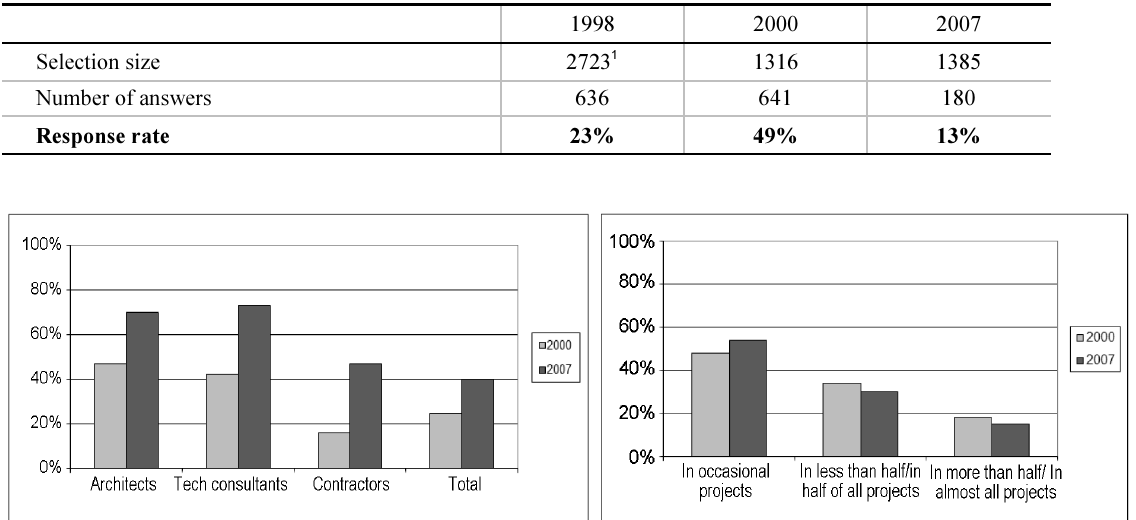
Table 1. Response rate for the surveys in the earlier parts of the study. The survey was conducted via paper mail in 1998 and 2000 and using a web questionnaire in 2007, which explains the lower response rate in the last phase